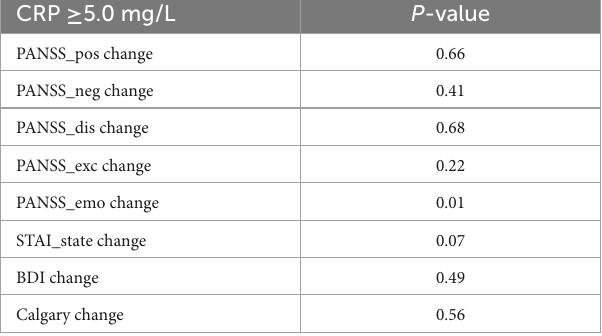
TABLE 1b Statistical association between elevated C-reactive protein levels at admission and change in the patients’ psychological state after 12 weeks of unified pharmacological